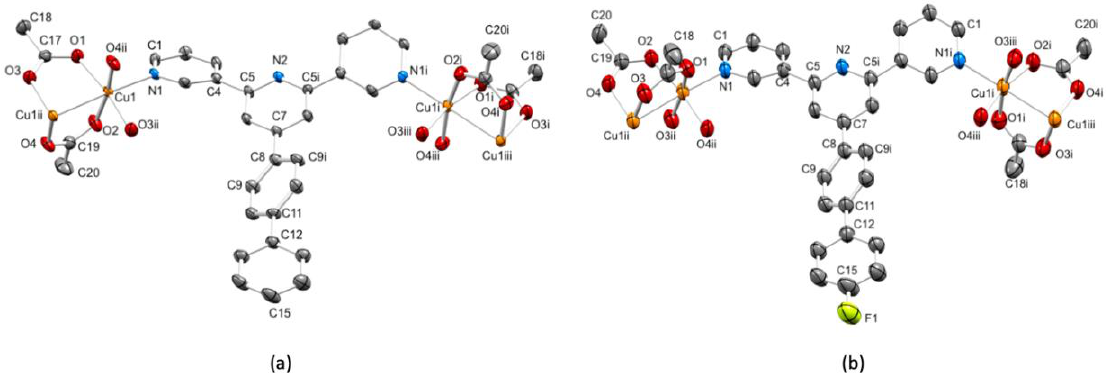
Figure 3. The repeat units (with symmetry generated atoms) in ( a ) [Cu 2 ( µ -OAc) 4 ( 2 )] n (ellipsoids plotted at 50% probability level; symmetry codes: i = 1 − x , y , 3 / 2 − z ; ii = 3 / 2 − x , 1 / 2 − y , 1 − z ; iii = − 1 / 2 + x , 1 / 2 − y , 1 / 2 + z ) and ( b ) [Cu 2 ( µ -OAc) 4 ( 2 )] n (ellipsoids plotted at 40% probability level; symmetry codes: i = 1 − x , y , 1 / 2 − z ; ii = 1 / 2 − x , 3 / 2 − y , 1 − z ; iii = 1 / 2 + x , 3 / 2 − y , − 1 / 2 + z ). H atoms are omitted for clarity.